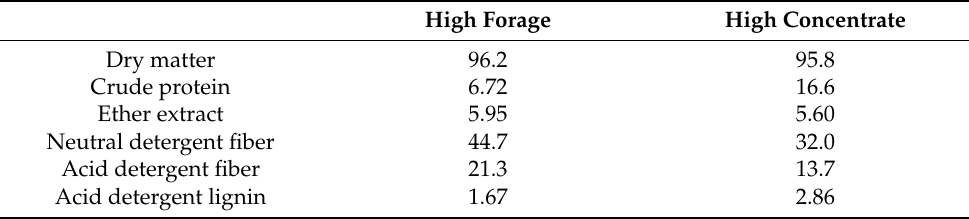
Table 1. Chemical composition (% dry matter) of the basal substrate used in ruminal in vitro incuba- tions ( n =